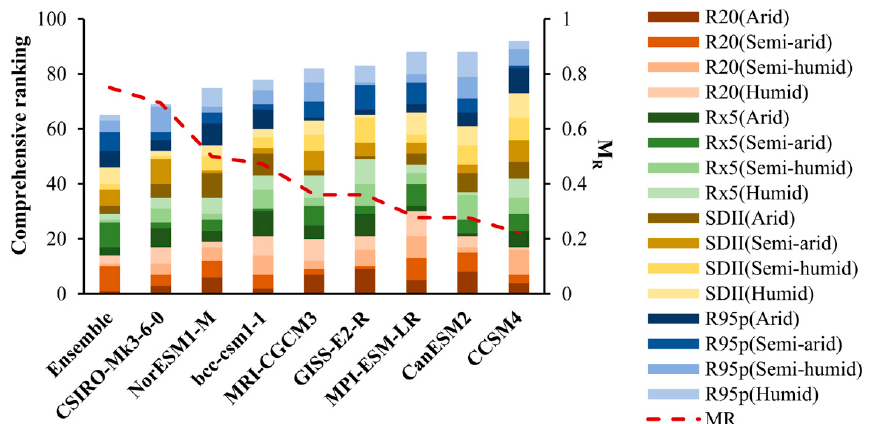
Figure 3. Comprehensive model ranks of 8 CMIP5 models and multi-model mean ensemble for simulating precipitation indices.